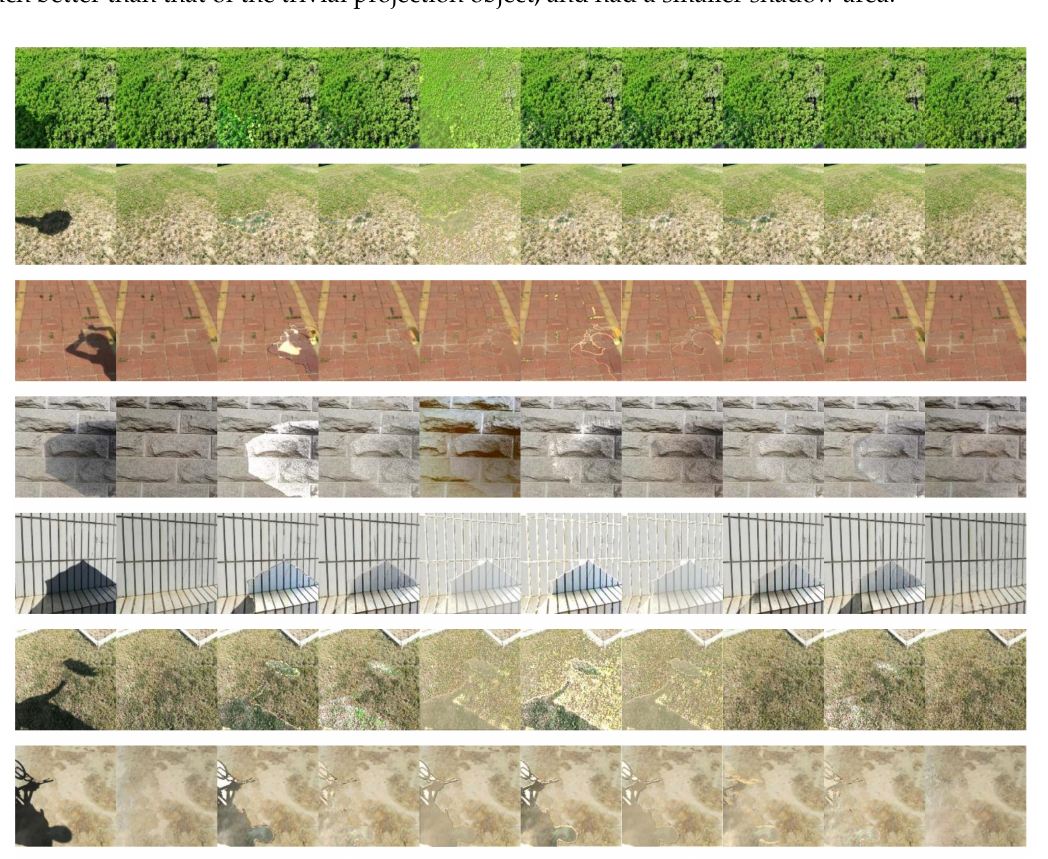
Figure 4. Schematic diagram of shadow removal in complex